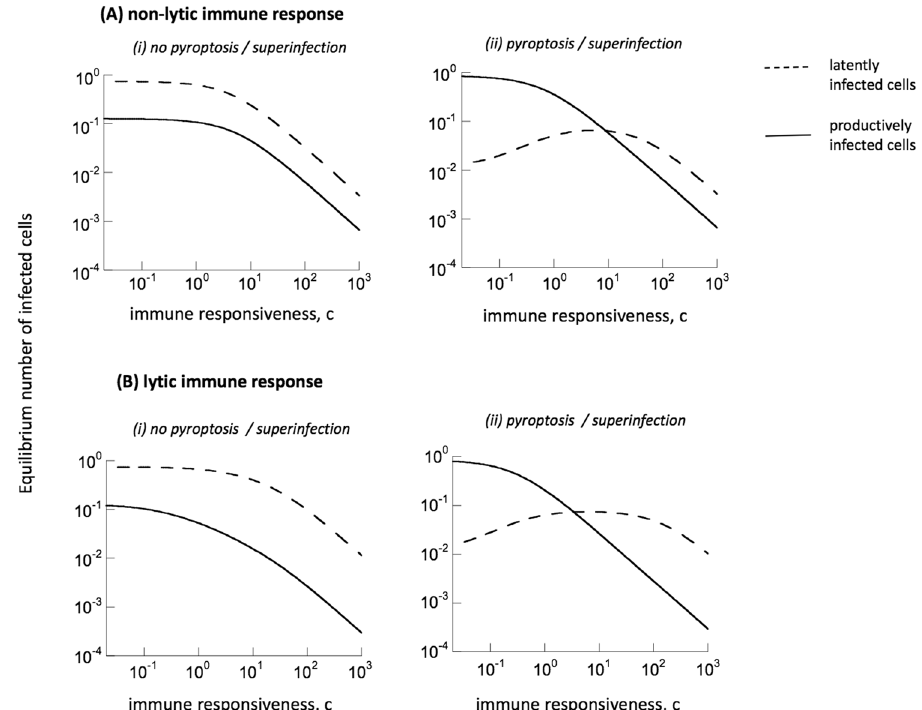
Figure 2. Exploring the relative equilibrium abundance of productively (solid line) and latently infected (dashed line) cells in chronic infection models (2/3). The graphs plot the equilibrium cell populations as a function of the immune responsiveness parameter c. Model (2) without pyroptosis/superinfection is compared to model (3) with pyroptosis/superinfection of latently infected cells. ( A ) The models assume a non-lytic immune response. Parameters were chosen as follows: a = 0.45 d − 1 , a 0 = 0.003 d − 1 , g = 0.001 d − 1 , β = 3.6/ (dayxcells), q = 0.95, p 1 = 1/(dayxcells) b = 0.1 d − 1 , f = 1/7. ( B ) The models assume a lytic immune response. Parameters were chosen as follows: a = 0.45 d − 1 , a 0 = 0.003 d − 1 , g = 0.001 d − 1 , β = 3.6/(dayxcells), q = 0.95, p 2 = 1/(dayxcells), b = 0.1 d − 1 , f =